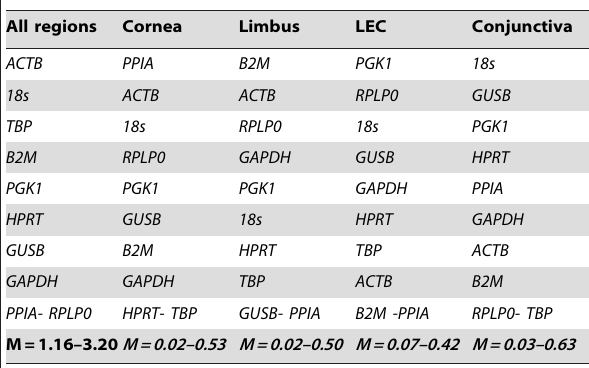
M value represents the average expression stability of the endogenous control genes pairs. Abbreviations used in the table: LEC: limbal epithelial crypt,